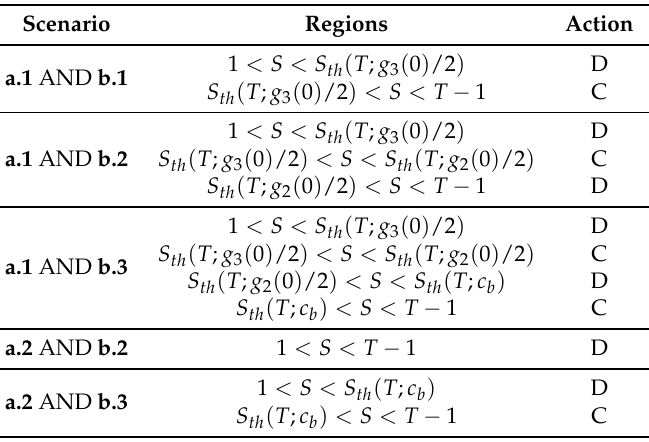
Table A1. The five possible scenarios for the actions taken by Level-3 players of the SG game in the octant 1 < S < T − 1. See the main text for explanations of the